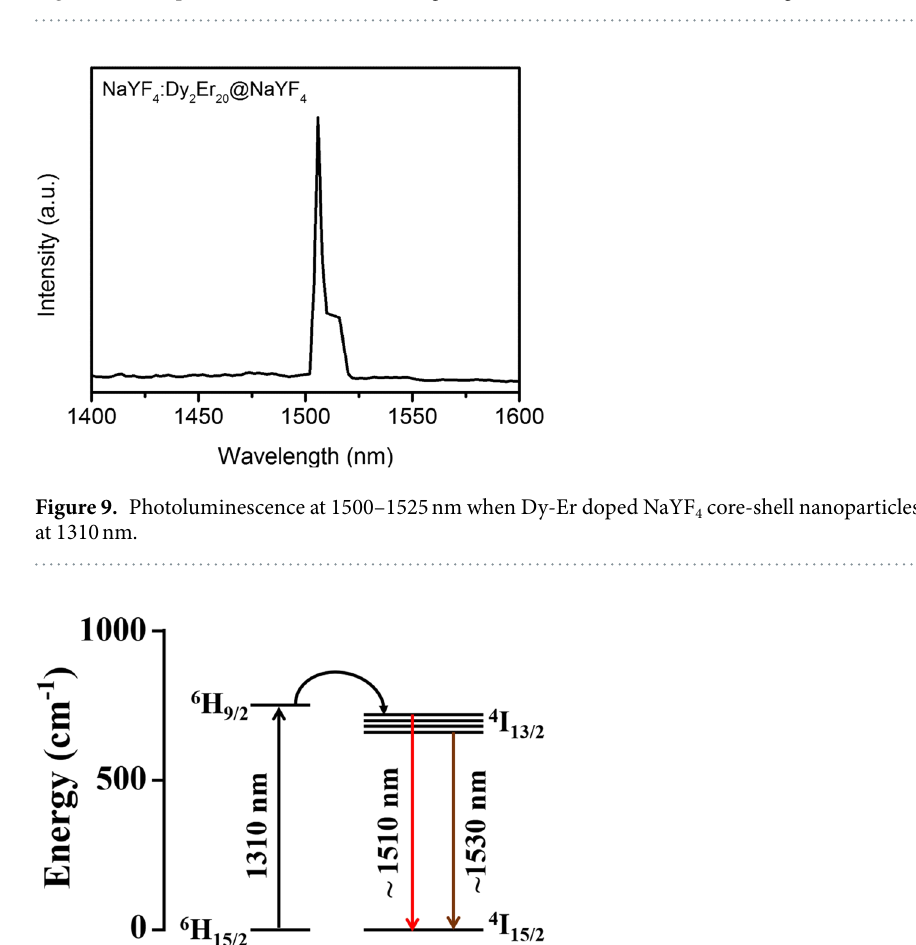
Figure 8. Group index for the channel waveguides with different width ( W ) and height ( H ).